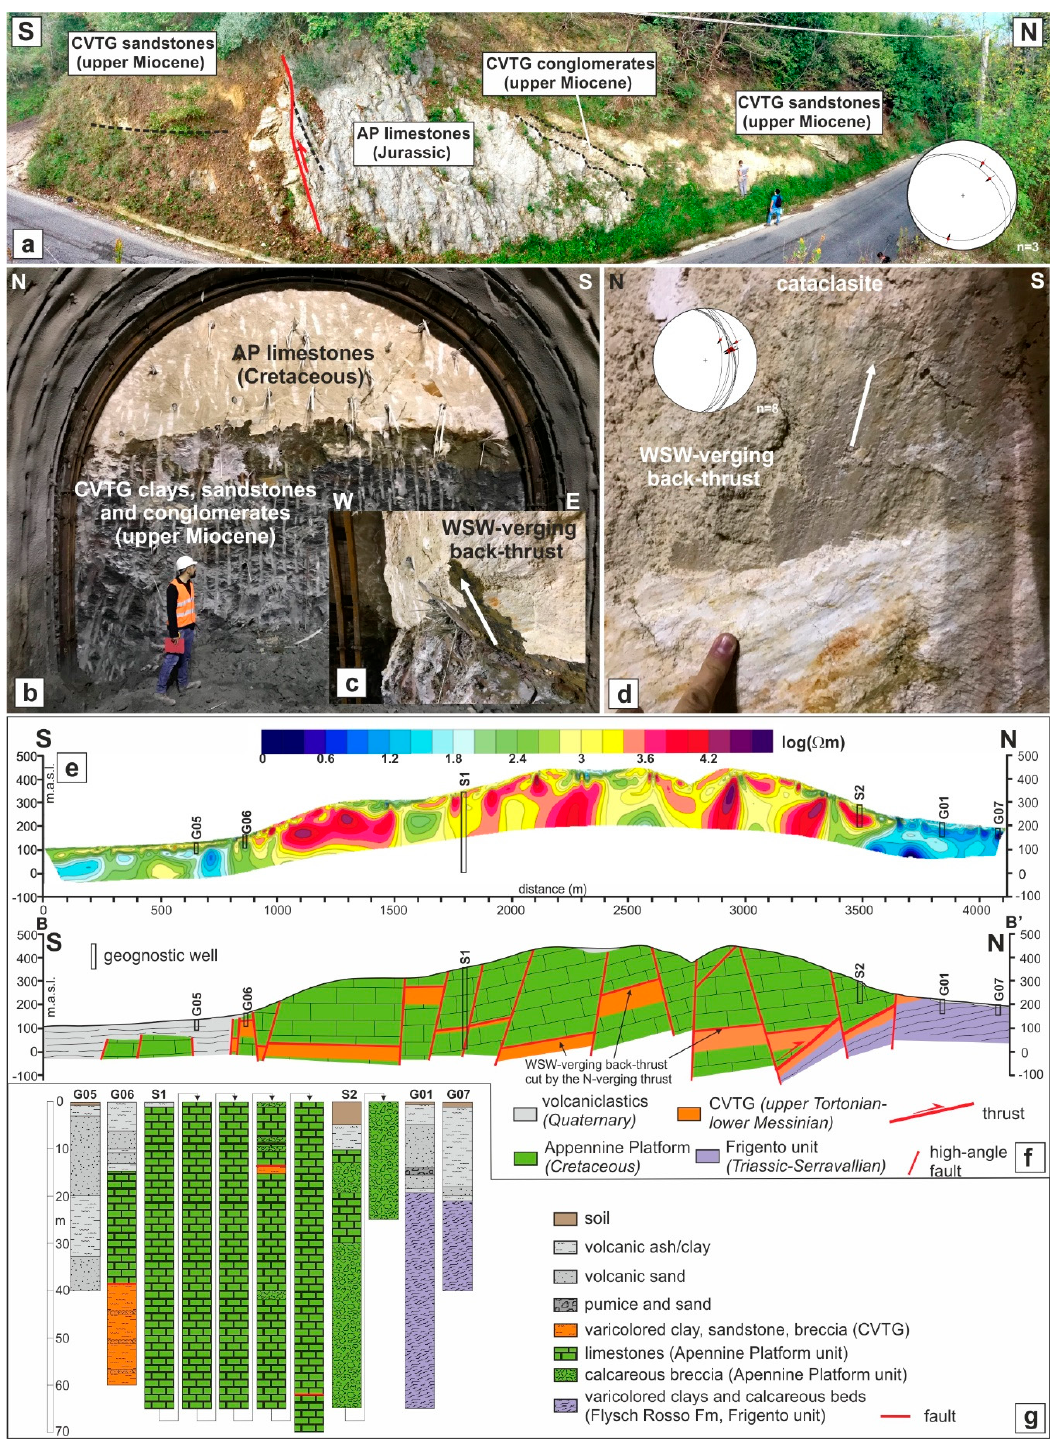
Figure 9. ( a ) Back-thrust of Apennine Platform (AP) Jurassic limestones onto CVTG sandstones (Limatola). Maddaloni Tunnel: ( b ) excavation front showing the tectonic superposition of the AP Cretaceous carbonates onto the CVTG; ( c ) particulars of the back-thrust plane; ( d ) slickenside striations and stereographic projections of thrust faults. ( e ) ERT profile; ( f ) cross-section; ( g ) well logs.